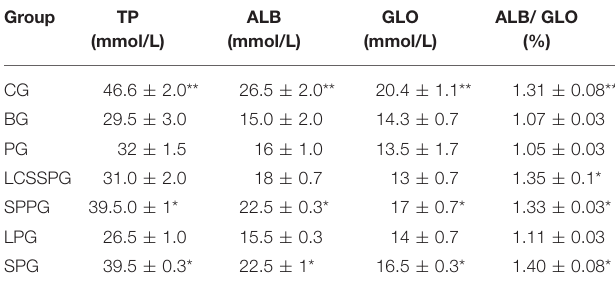
TABLE 5 | Effect of different enteral formula on TP, ALB and GLO in high fat diet induced mice.